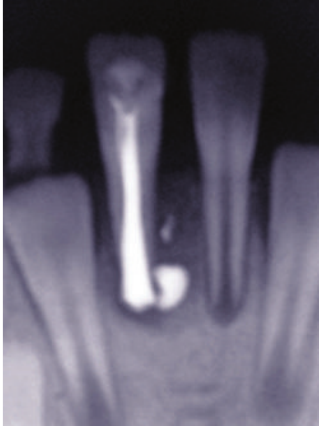
Figure 8: Twenty-month follow-up radiograph; continued root for- mation is very